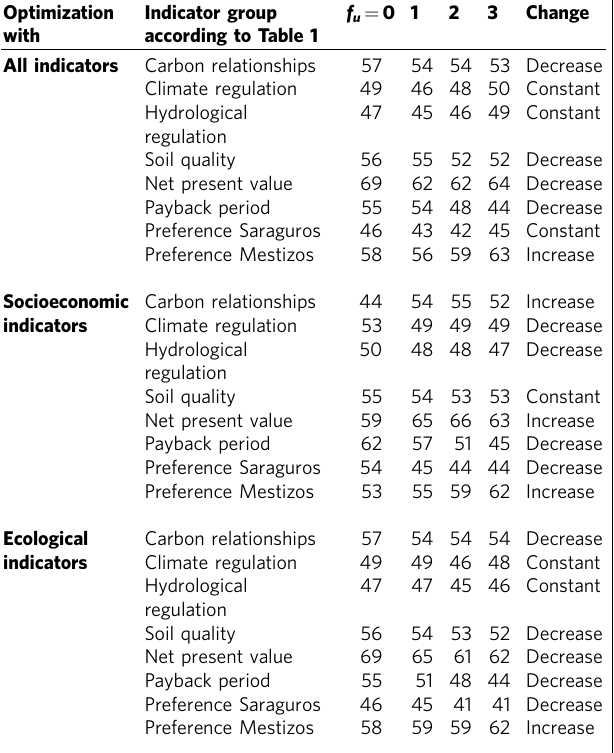
Table 3 | Changes for adapting to uncertainty: achieved average min–max normalized indicators after optimization with various indicator sets for increasing levels of uncertainty (changes of ± 2% were denoted as